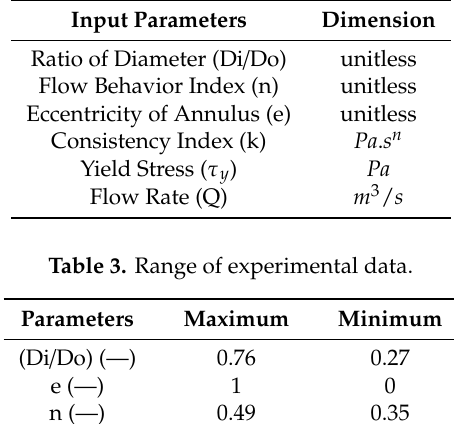
Table 2. Input parameters for the proposed data mining algorithms.